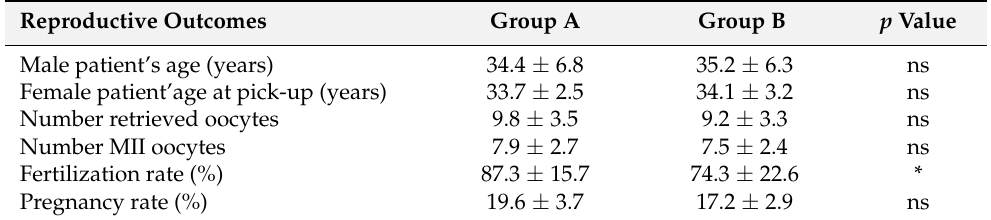
Table 6. Reproductive Outcomes of IVF cycle between Group A and Group B (* p < 0.05). Reproductive